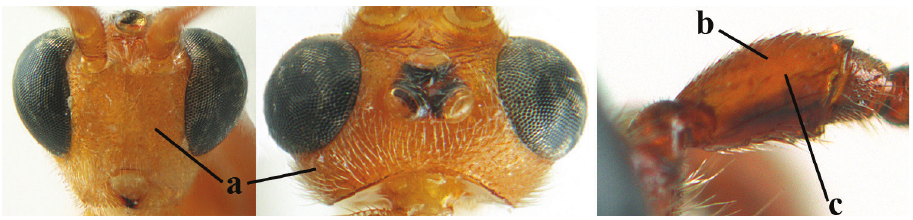
dark brown (bb) and less robust in lateral view (cc) .................................. 11